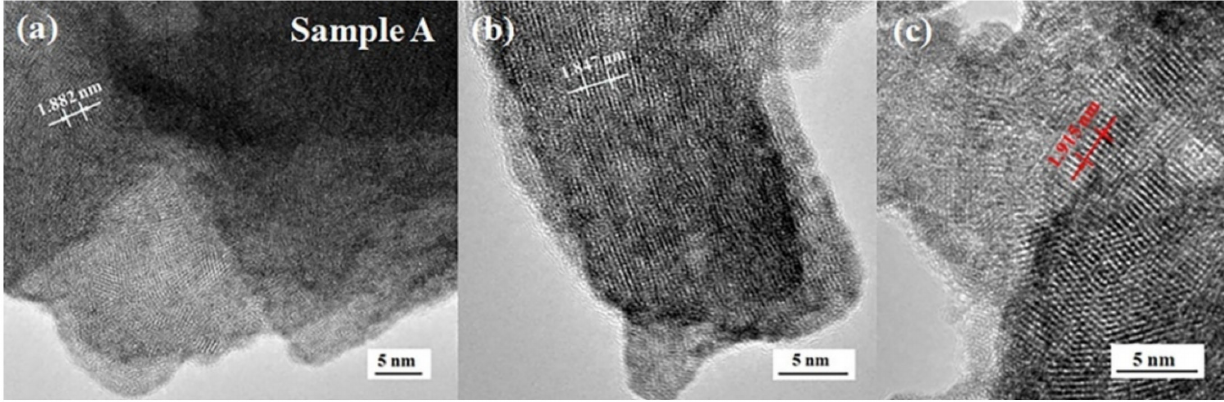
Figure 6. TEM images of sample A, which indicate that the nanoflake ( a ), nanorod ( b ) and nanoparti- cle ( c ) are the crystal structure with the lattice spacing of ~0.376, 0.369 and 0.383 nm,